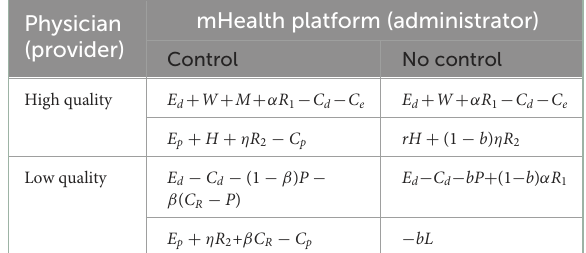
TABLE 1 Behavioral choices and game payment matrix for health information providers and managers of mHealth